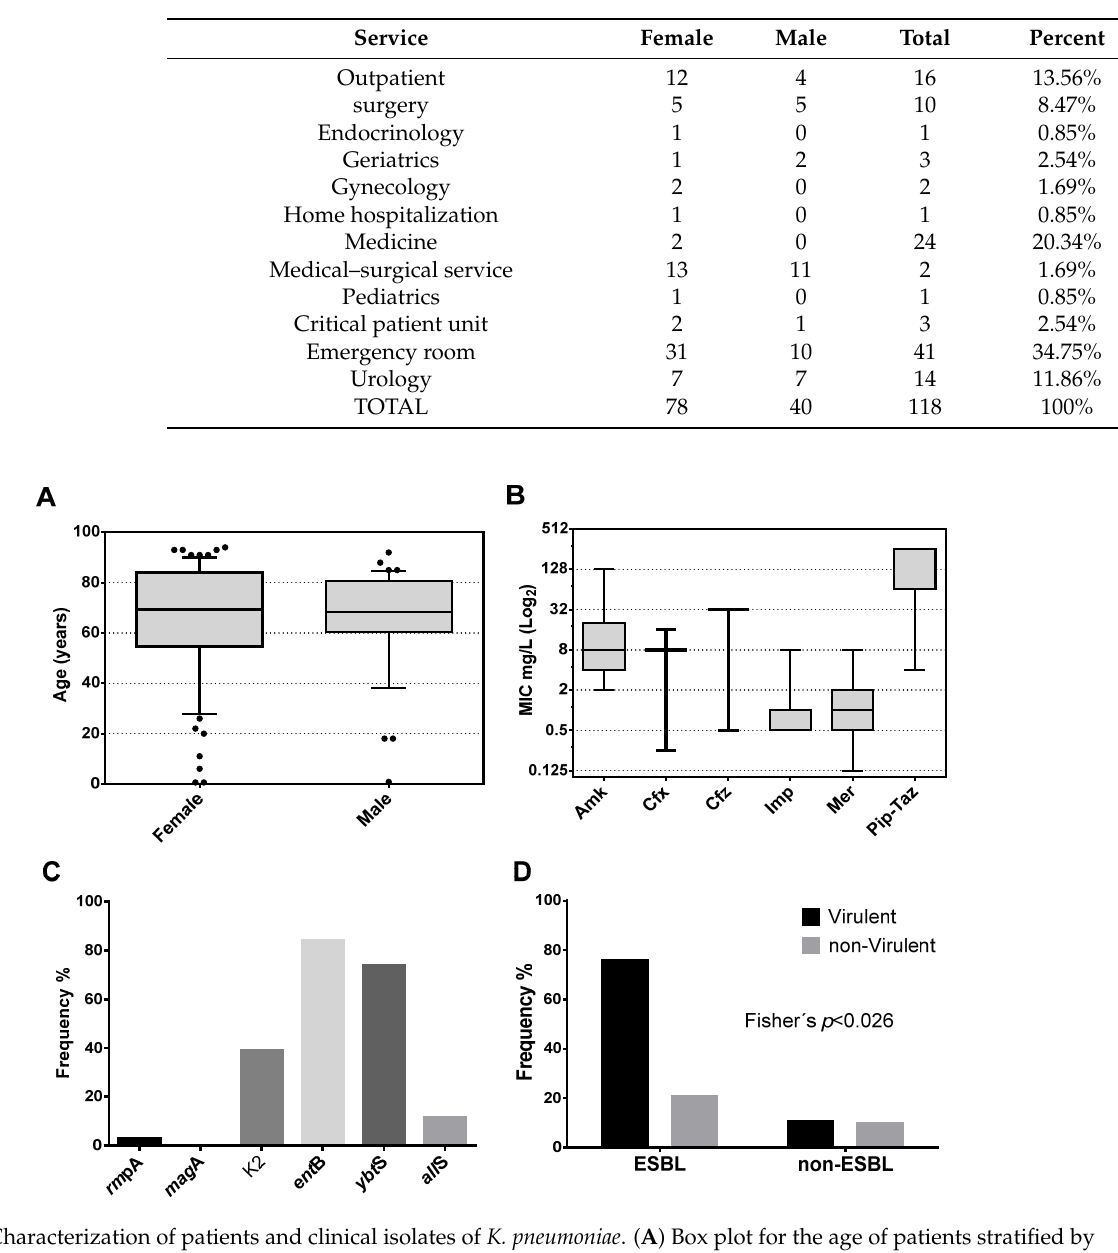
Figure 1. Characterization of patients and clinical isolates of K. pneumoniae . ( A ) Box plot for the age of patients stratified by gender. Patients show a median of 69.5 years for females and 68.5 years for males. ( B ) Box plot showing the median in the population of the minimum inhibitory concentration (MIC) of the seven antibiotics commonly used to treat infections by Gram-negative bacteria. ( C ) Frequency of carrying of the six genes evaluated in the study population. ( D ) Frequency distribution of carriers of three or more virulence factors stratified by extended-spectrum beta-lactamase (ESBL) produc- tion.